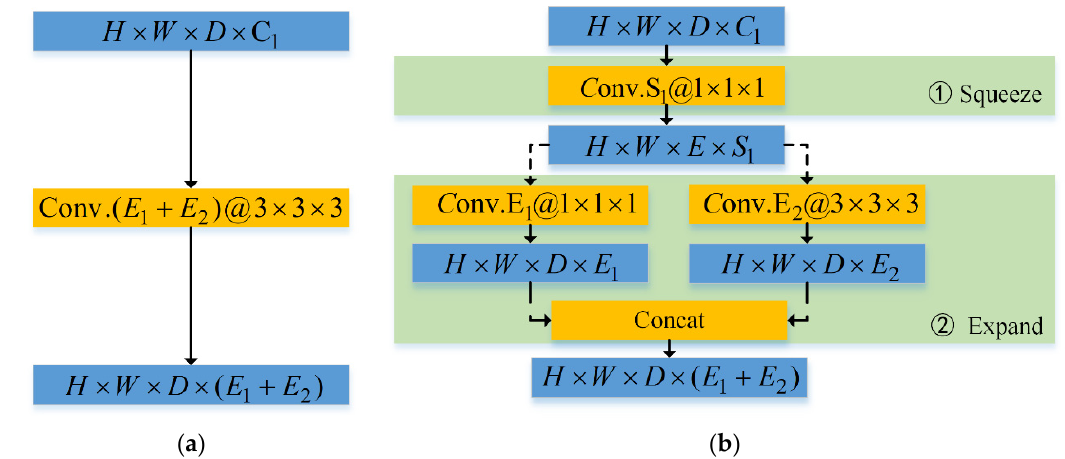
Figure 2. Schematic diagram of local network structure. ( a ) Direct connection of convolution layers ( b ) ‘Fire’ module.